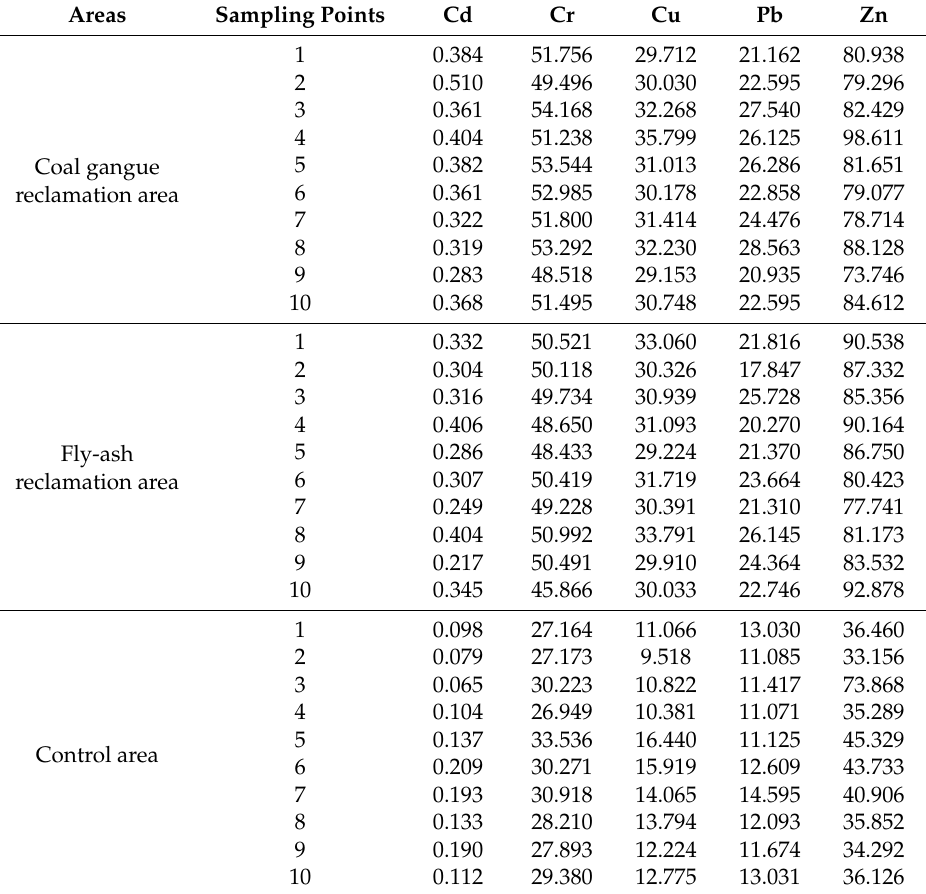
Table 1. Heavy metal concentrations of soil samples in the three different areas (mg/kg).